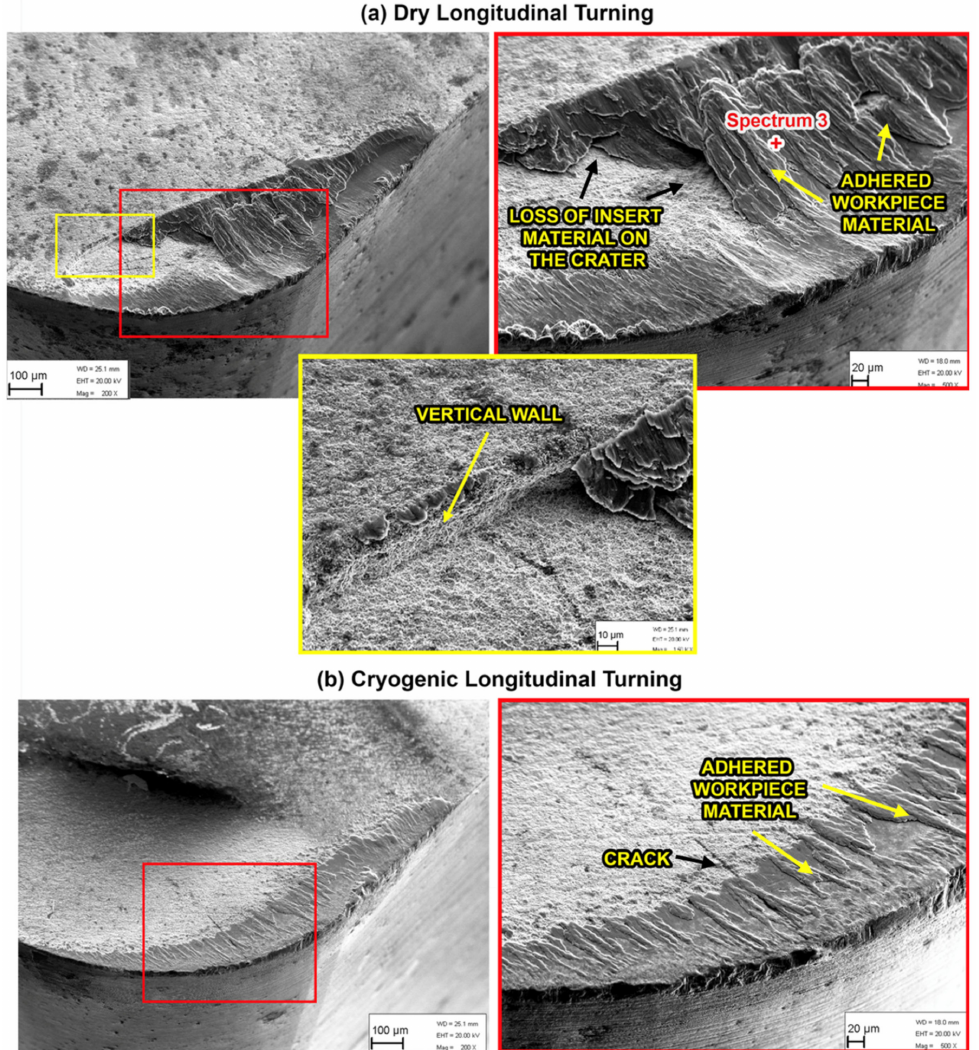
Figure 15. SEM images of the insert rake face for ( a ) dry and ( b ) cryogenic longitudinal